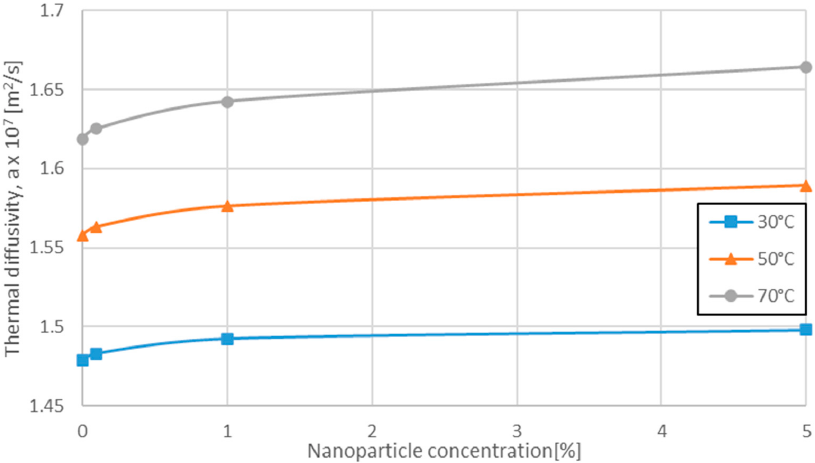
Figure 12. Thermal diffusivity of water-Al 2 O 3 nanofluids.